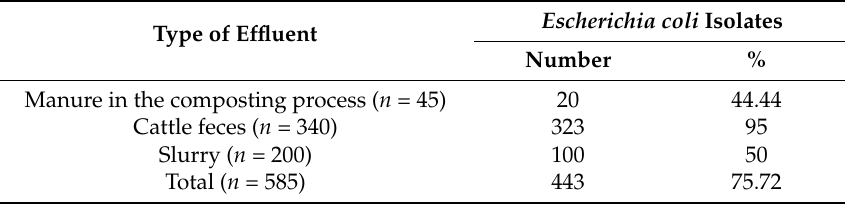
Table 2. Prevalence of Escherichia coli in organic waste products from cattle